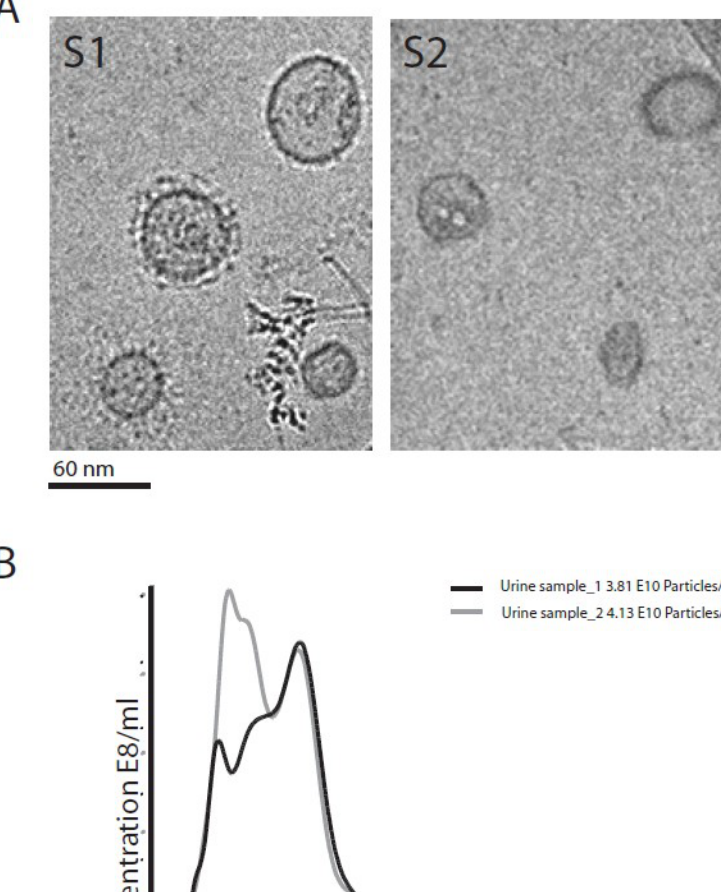
Figure 1. Characterization of EVs isolated from voided urine. Two different samples observed by electron microscopy image ( A ), size profile determined by NTA ( B ) and the RNA profile after RNA extraction from EVs ( C